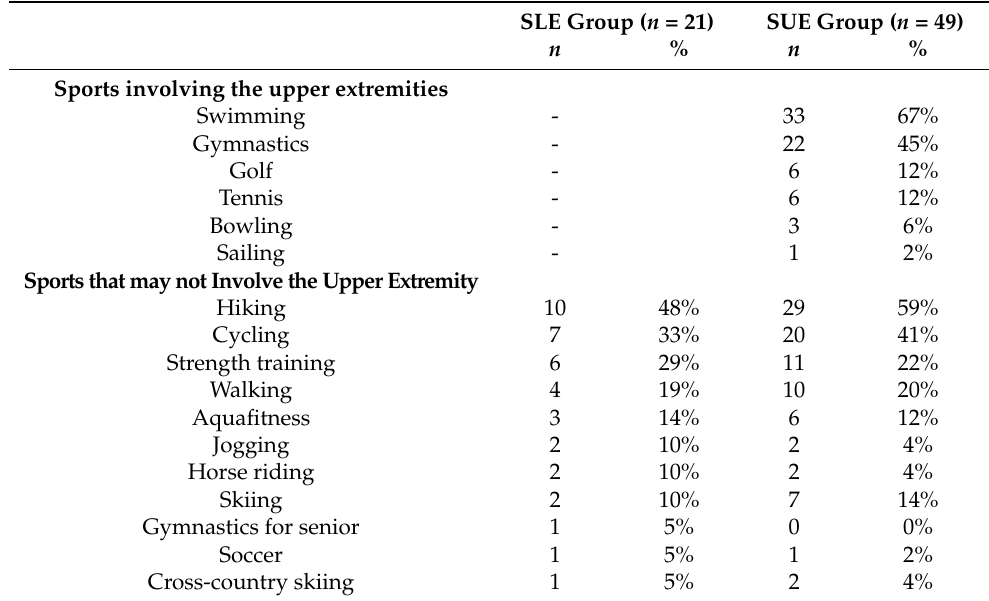
Table 1. Type of sports practiced between return-to-sport groups SLE and SUE.